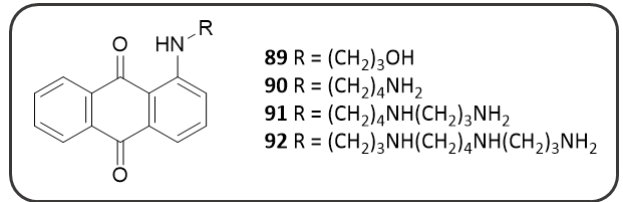
Figure 17. Hong, C. et al. aromatic-polyamine derivatives as ChE inhibitors.